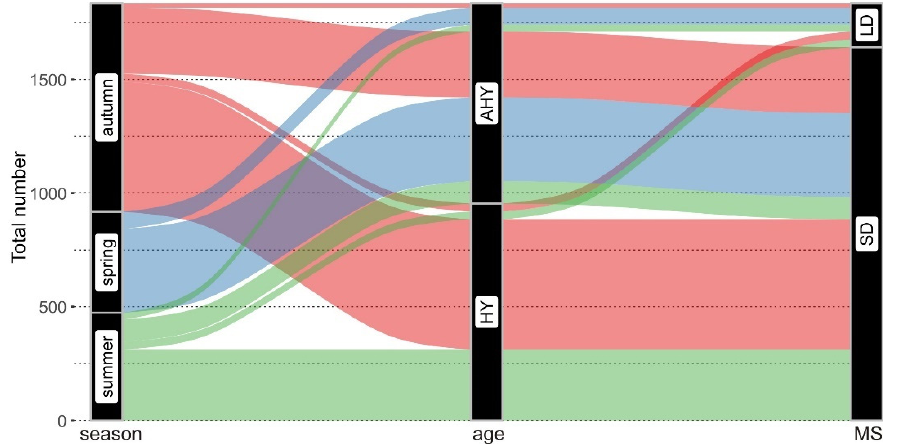
Figure 2. Alluvial plot describing the community structure of birds captured in Drienovec, Slovakia, during 2017, 2018 and 2019. Community structure is described in terms of time of year (spring, summer, autumn), age (HY: hatch-year; AHY: after-hatch-year), and migration strategy (SD: short- distance migrants; LD: long-distance migrants). Table 1. List of avian species sampled and haemosporidian parasites detected in Drienovec, Slovakia, during 2017, 2018 and 2019. For each bird species we report migratory strategy (MS: SD = short-distance migrant, LD = long-distance migrant), number of sampled individuals during three years and for two age classes (AHY: after-hatch-year, HY: hatch- year), haemosporidian prevalence in percent (proportion), values of structural parasite specificity in terms of the d’ index ( d’ H, P and L: specificity for Haemoproteus , Plasmodium and Leucocytozoon lineages, respectively), and haemosporidian cytochrome b lineages (H: Haemoproteus , P: Plasmodium and L: Leucocytozoon ). New lineages are in bold. Note that it was not possible to identify lineage for each positive sample while multiple lineages were often identified in individual blood samples. Furthermore, the d’ index was not possible to calculate for each parasite genus due to sample size limitations. Sample sizes for prevalence may not correspond with the number of sampled birds per species as it was not possible to determine infection status for some ( n = 76) of the samples.